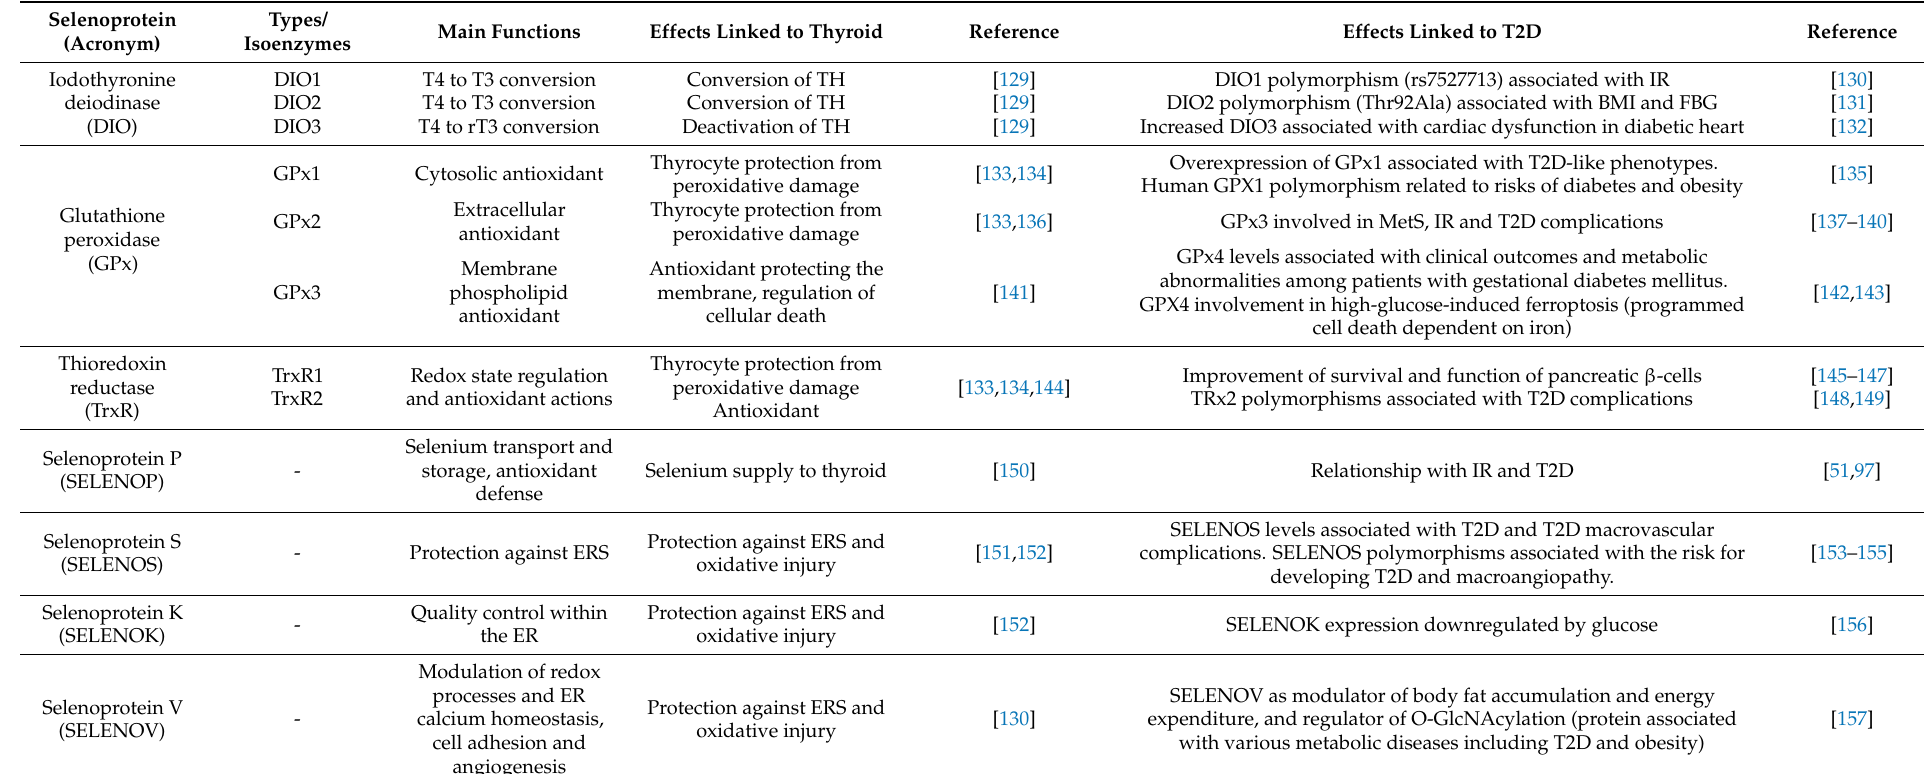
Table 2. Selenoproteins involved in thyroid health and type 2